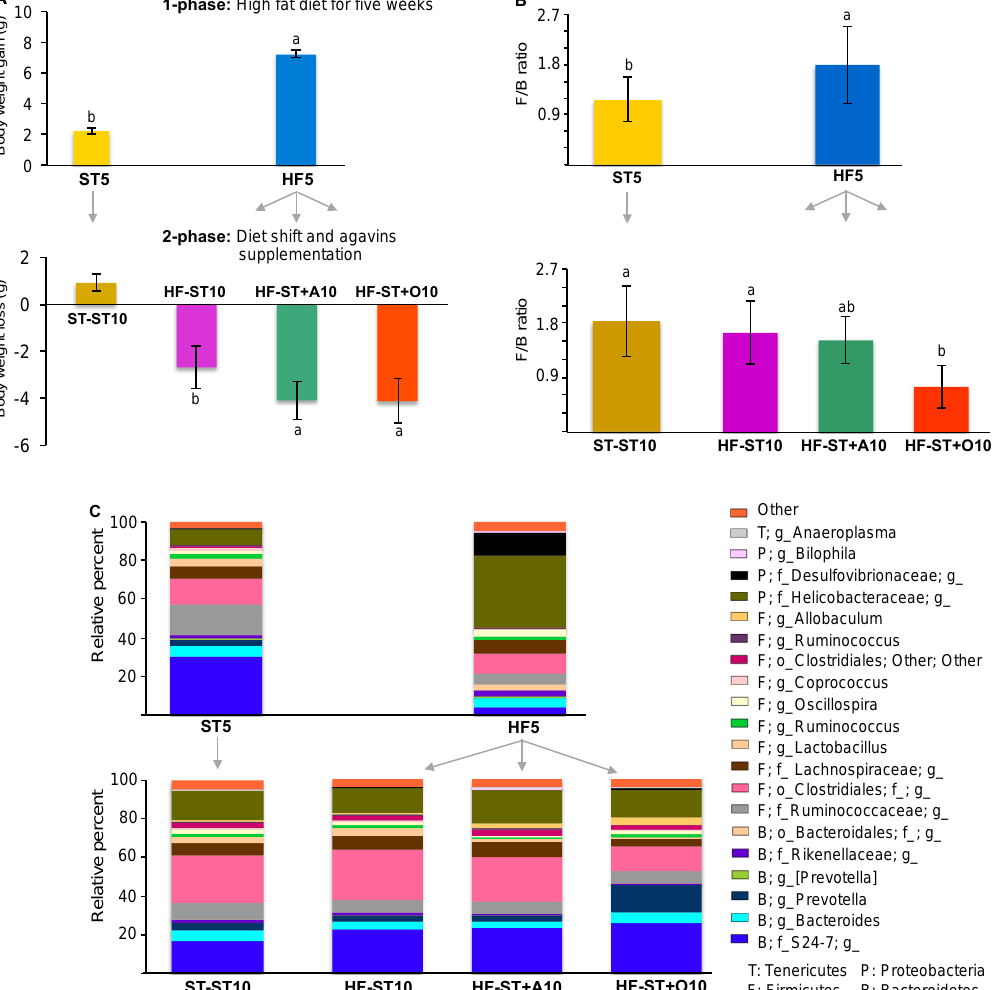
Figure 2. The effect of the diet shift and prebiotic supplementation on body weight loss and cecal microbiota composition in overweight mice. Body weight loss ( A ); Firmicutes/Bacteroidetes (F/B) ratio after the switch to a standard diet alone, or supplemented with agavins or oligofructose ( B ); differences in relative abundance of bacterial taxa in cecum according to diet group ( C ). Each taxon representing > 1% of the average relative abundance in study groups is indicated by a different color.